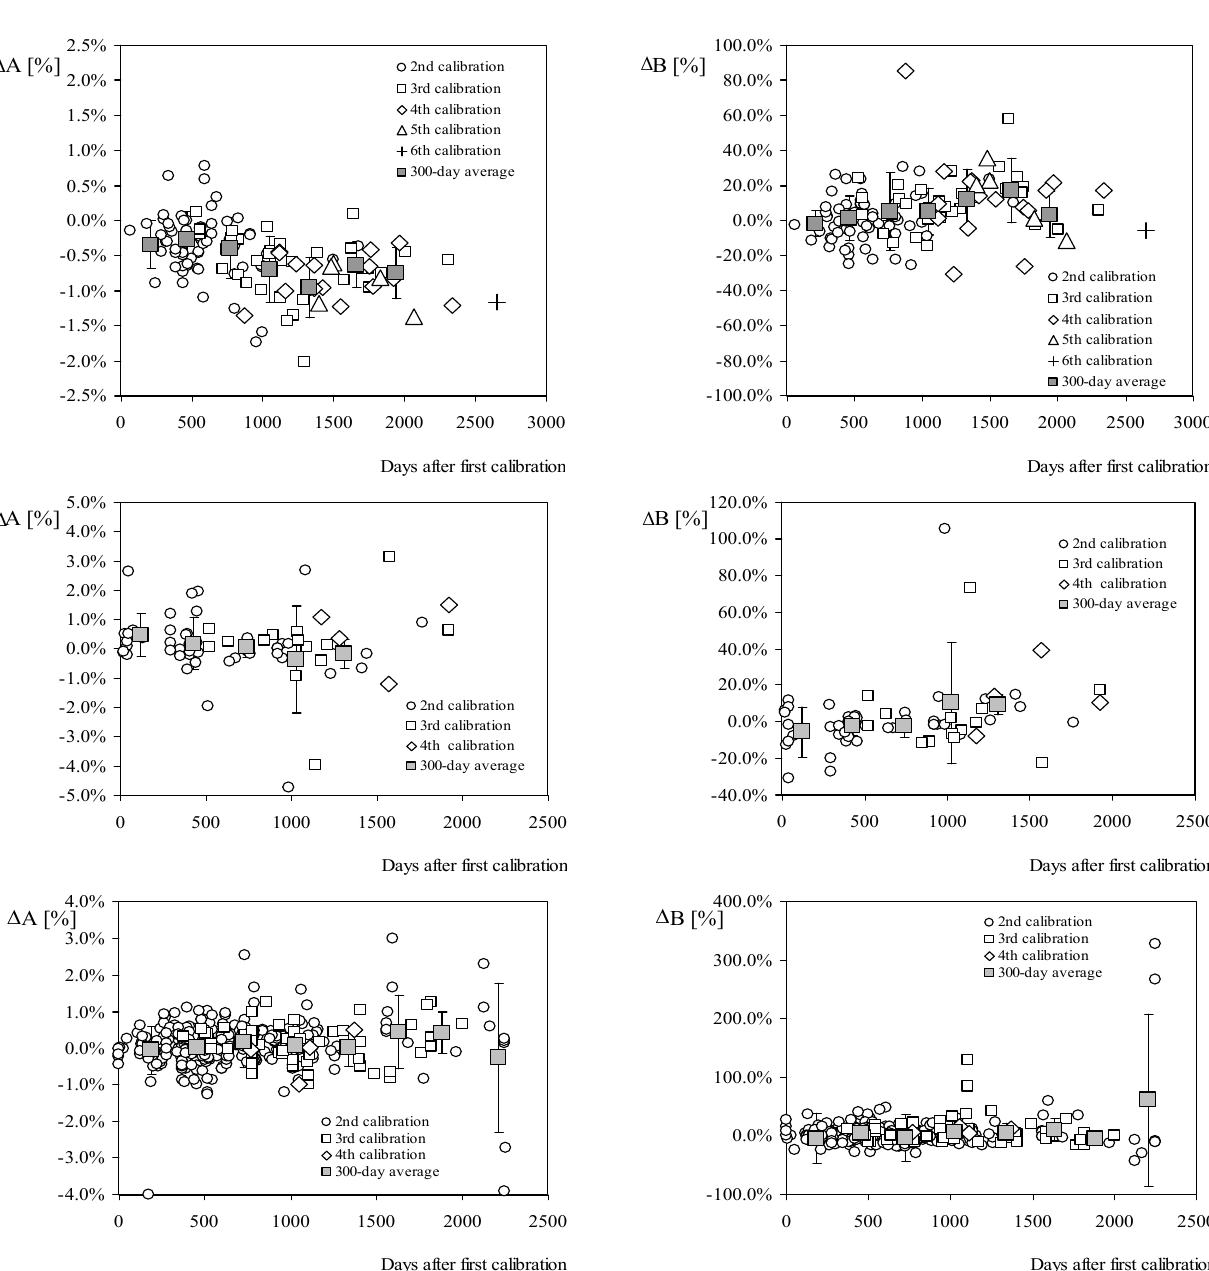
Figure 6. Percentage variation of calibration constants A and B from the initial values with regard to Risø P2546 (top), Thies Clima 4.3303 (middle), and Thies Clima 4.3350 (bottom) anemometers calibrated several times at the IDR/UPM Institute. The 300-day average value has been included, together with the standard deviation